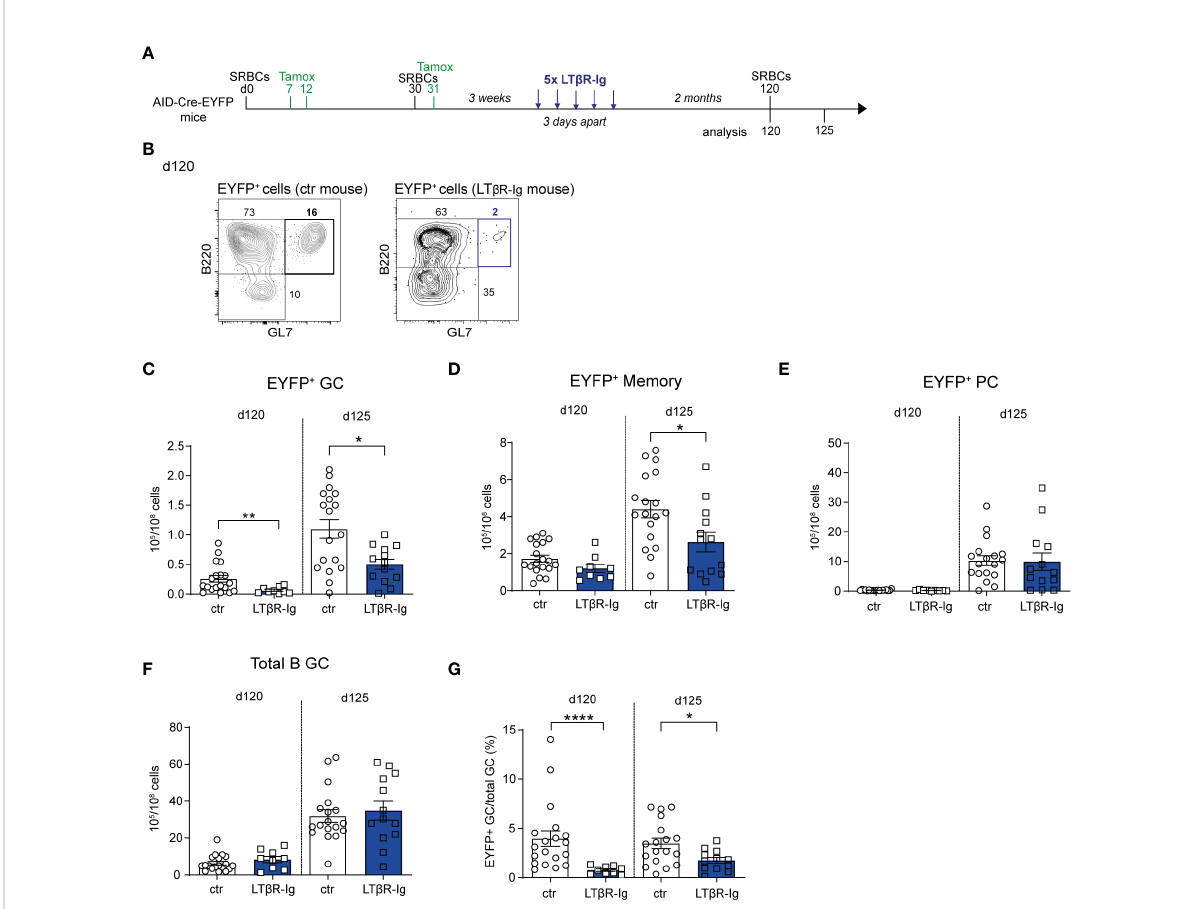
FIGURE 4 The presence of persistent GCs impacts recall GC B cell responses . (A) AID-Cre-EYFP mice were immunized twice with SRBCs (d0 and 30) and received tamoxifen upon prime and boost (d7, 12, 31). Three weeks after boost, a group of mice was i.v. injected with LT b R-Ig fusion protein 5 times 3 days apart. Spleen cells from treated and control (ctr) mice (that were immunized similarly without LT b R-Ig injection) were analyzed by fl ow cytometry before (d120) or 5 days after (d125) a tertiary SRBC injection performed on d120. (B) Representative fl ow cytometry plots showing the depletion of EYFP + GL7 + GC B cells in LT b R-Ig-treated mice on d120. EYFP + GC (C) , memory (D) , PC (E) , and total B GC (F) cell numbers are shown for control and treated mice on both d120 and 125. The fraction of EYFP + GCs among total GC B cells is shown in panel (G) Each point in the graphs represents an individual mouse from at least two independent experiments. Means ( ± SEM) are shown. Mann Whitney test was used to compare control and treated mice at the two time points analyzed. *p<0.05, **p<0.01, ****p<0.0001. ctr=control